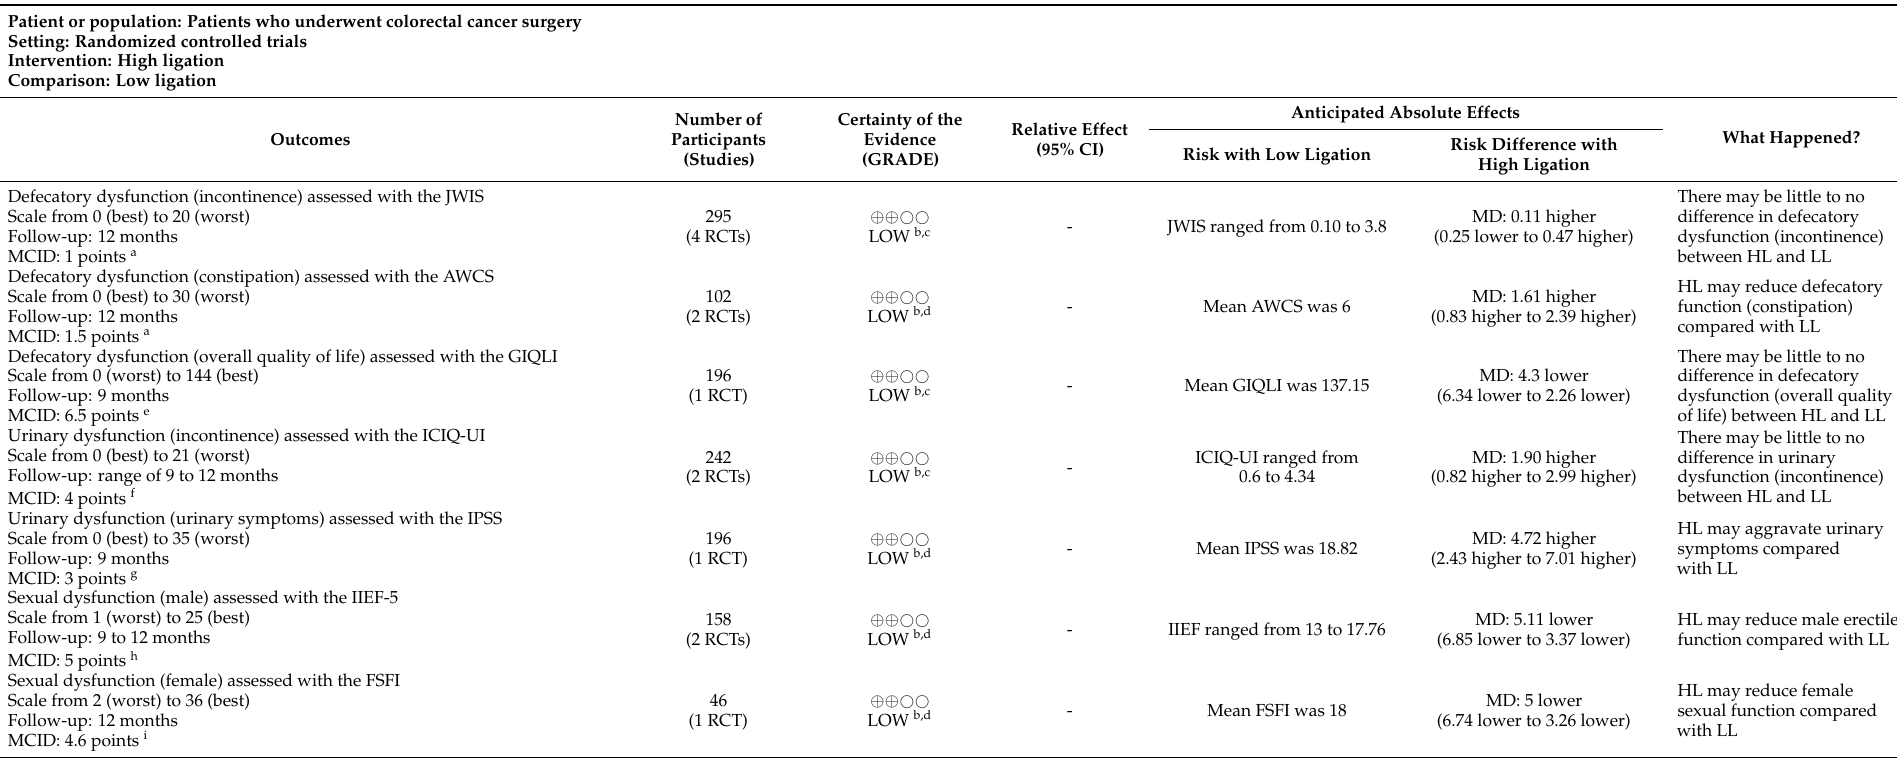
Table 4. Summary of findings: Defecatory, urinary, and sexual dysfunction between high ligation and low ligation in colorectal cancer